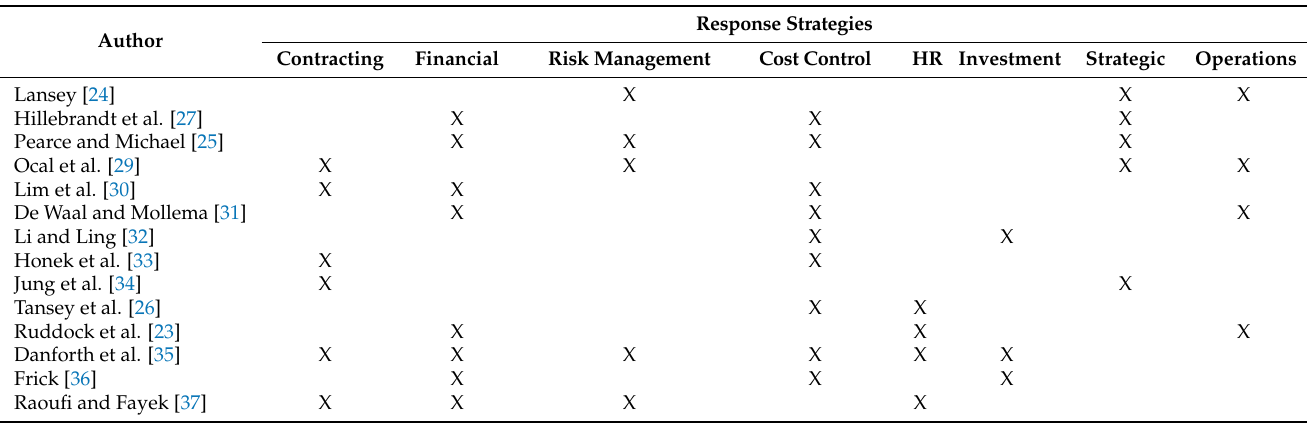
Table 1. Response